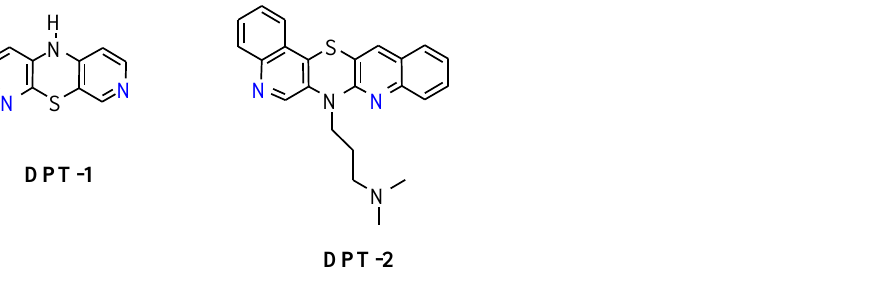
Figure 1. Structures of diazaphenothiazines DPT-1 (10 H -3,6-diazaphenothiazine) and DPT-2 (7-(3 ′ - dimethylaminopropyl)diquinothiazine).